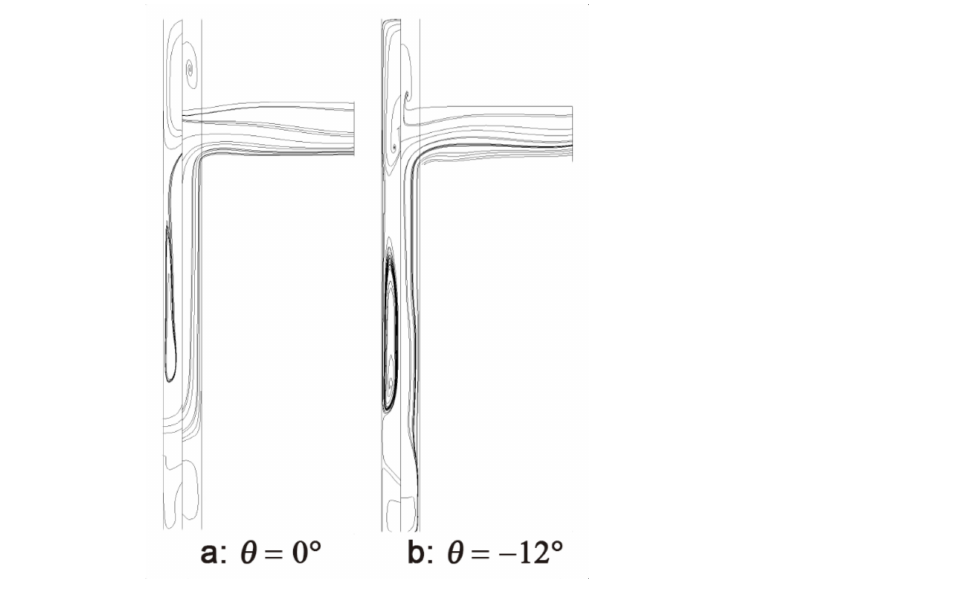
Figure 18. Streamlines at the z-r plane for G = 0.0231: ( a ) θ = 0 ◦ , ( b ) θ = − 12 ◦ .